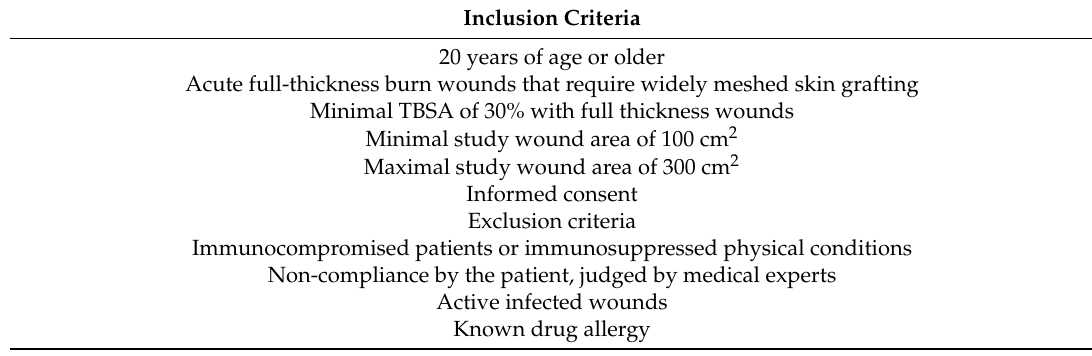
Table 5. Criteria for patients to participate in the present study. TBSA: total body surface